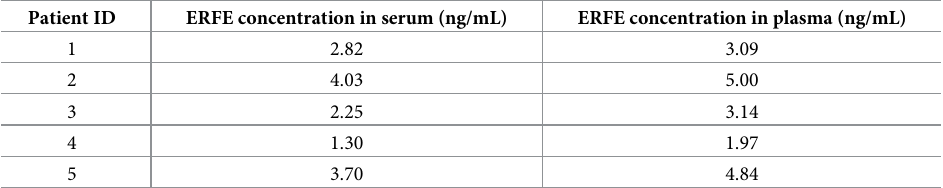
ERFE was measured in serum and heparin plasma samples of the same blood draw of 5 XLSA patients. ERFE concentrations in plasma were significantly higher compared to those measured in serum (paired one-tailed t-test, p =